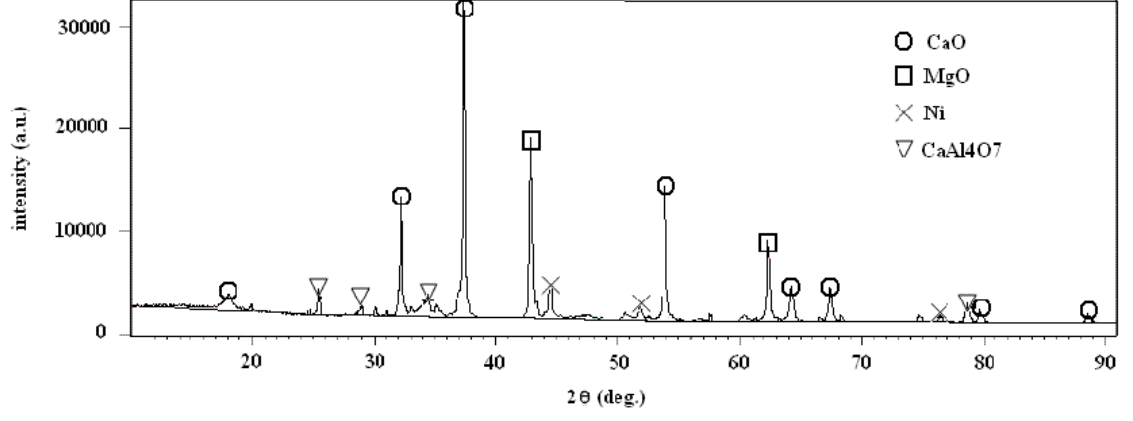
Figure 8. XRD analysis of the spent sorbent/catalyst after